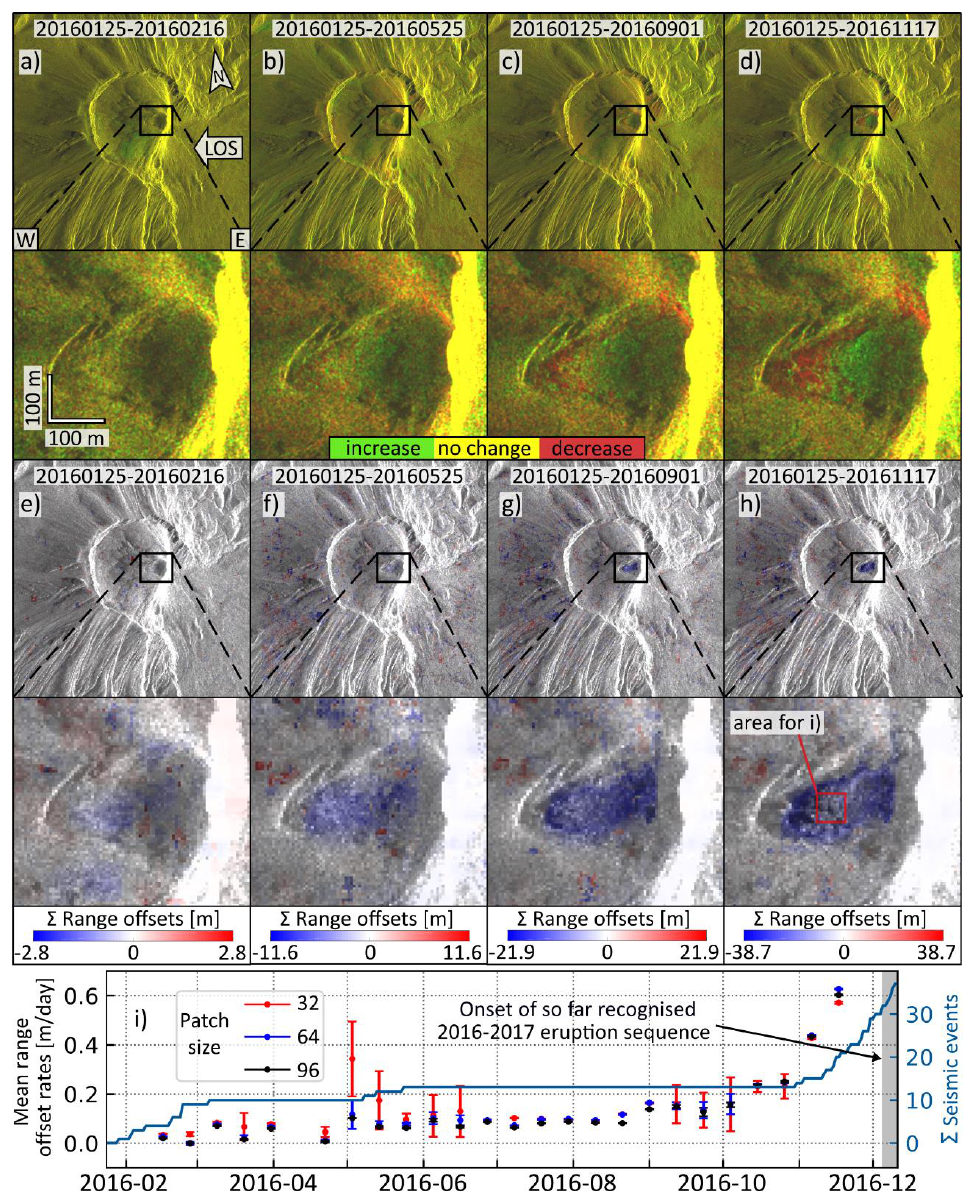
Figure 3. Eruption precursory deformation at Bezymianny between January and November 2017 determined in radar amplitude imagery change di ff erence maps ( a – d ). Close-ups of these maps show the gradual emergence of a rigid body that produces a successively larger radar shadow at the summit crater floor displayed by magenta